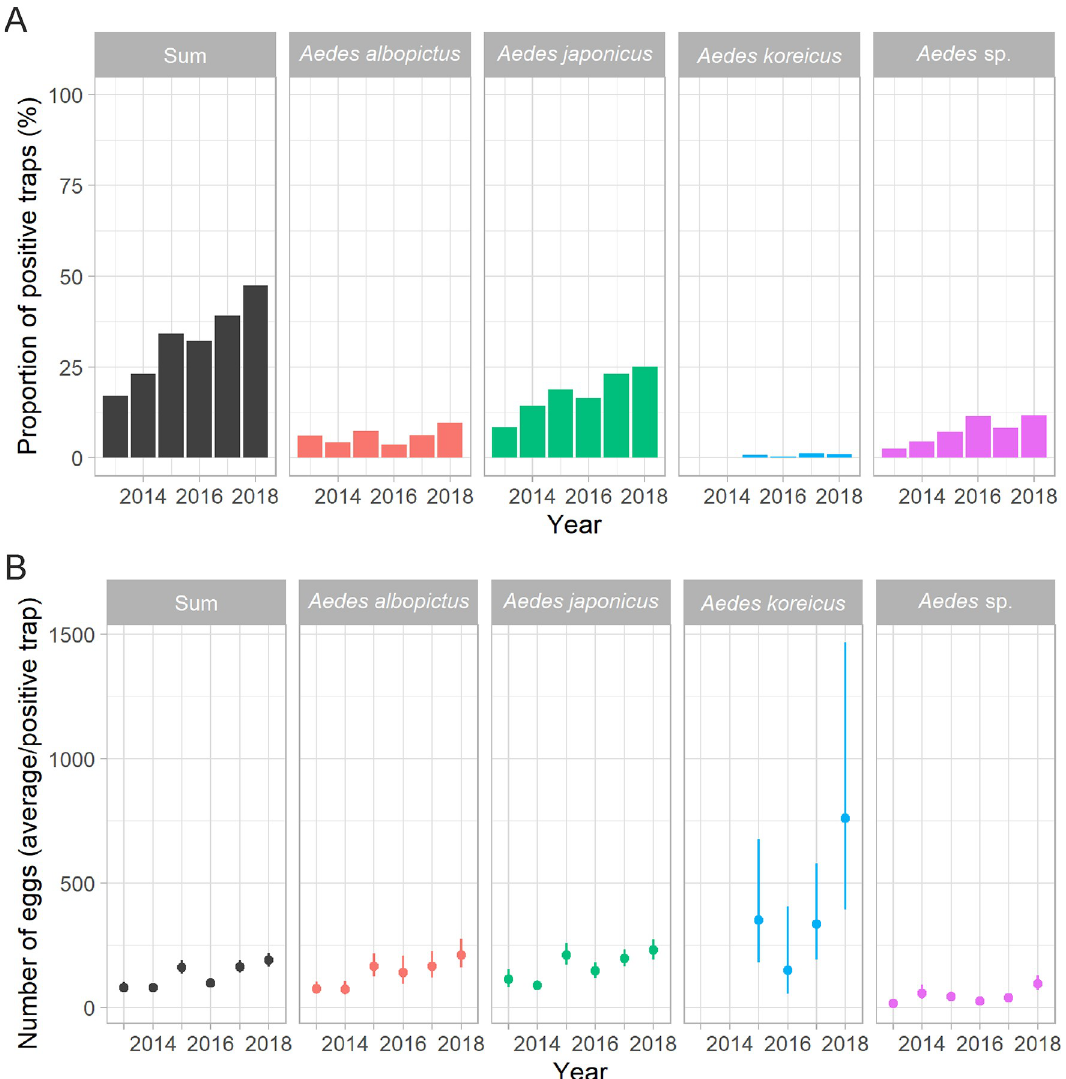
Fig 2. Trends in the number of positive ovitraps and egg counts between 2013 and 2018. (A) Proportion of ovitraps (i.e. slats) that had eggs. (B) Average number of eggs per trap among the positive traps (i.e. slats). Traps that had not been set throughout the entire study were removed from the analysis. The error bars indicate the 95% confidence intervals (95% CI) around the average estimated using the generalised linear models. The large 95% CI’s for Aedes koreicus are due to the low number of positive traps. " Aedes sp." denotes all counts associated with slats where the eggs were invasive Aedes species but could not be identified to species level.